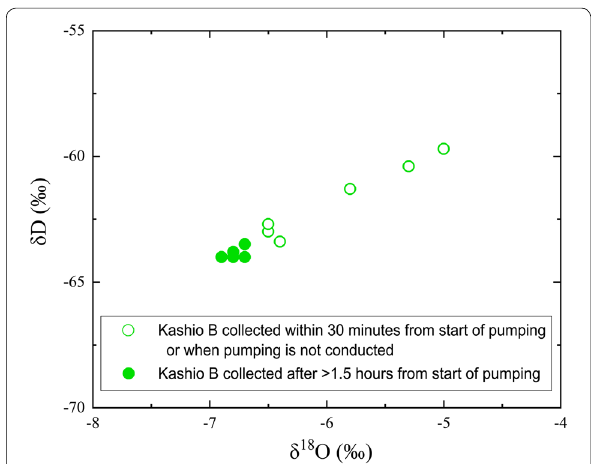
Fig. 5 Relationship between δD and δ 18 O in water samples from the Kashio B well. The data is plotted in two categories: within 30 min from the start of the commercial pumping (or when the pumping was not conducted) (open circles) and after > 1.5 h of pumping (filled circles). Variation of the former is wider than that of the latter